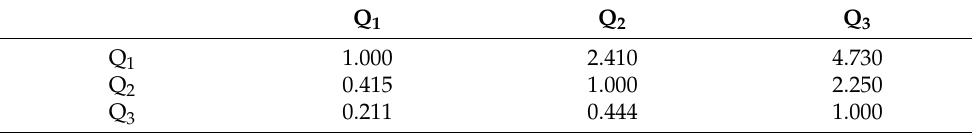
Table 6. Relative reciprocal weights for compared alternatives.